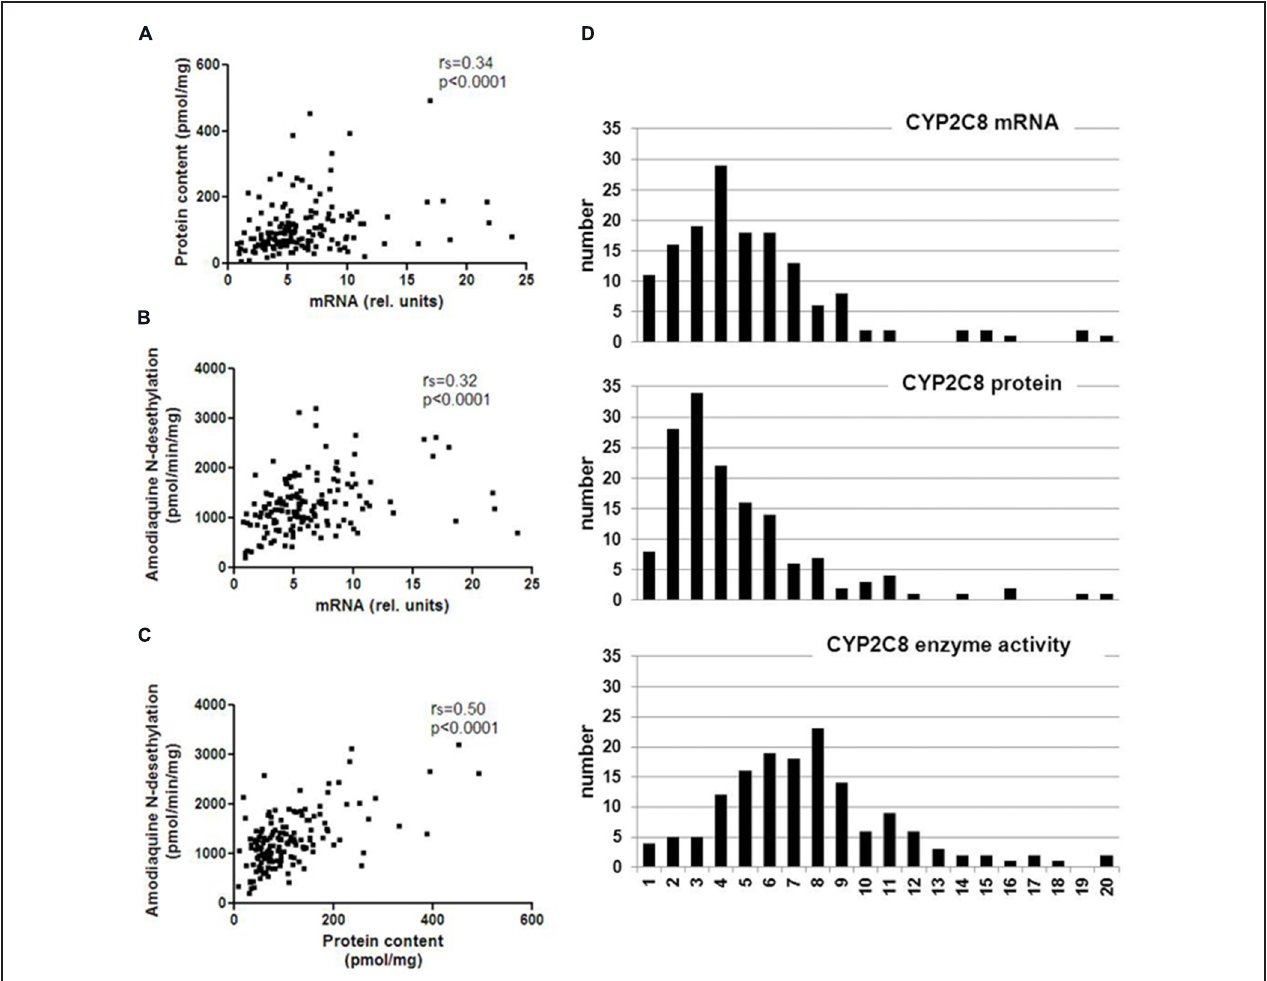
FIGURE 1 | Spearman correlations and population distribution of hepatic CYP2C8 phenotypes. CYP2C8 mRNA was determined by a specific TaqMan real-time RT-PCR assay, protein was determined by Western blotting and enzyme activity was measured by LC–MSMS analysis of amodiaquine N -desethylation in human liver microsomes ( n = 150). Results are means of duplicate measurements. (A–C) Spearman’s rank correlation coefficients are indicated as r s and statistical significance for all comparisons was p < 0.0001. (D) Histograms showing population distributions for mRNA (top), protein (middle), and enzyme activity (bottom) using 20 bins over the entire phenotype